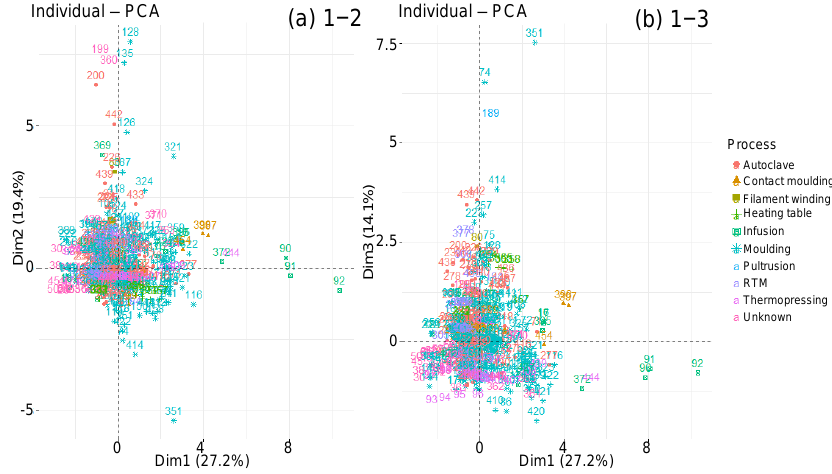
Figure 14. Graphs of individuals on planes ( a ) 1–2 and ( b ) 1–3 of the global PCA, according to manufacturing process.